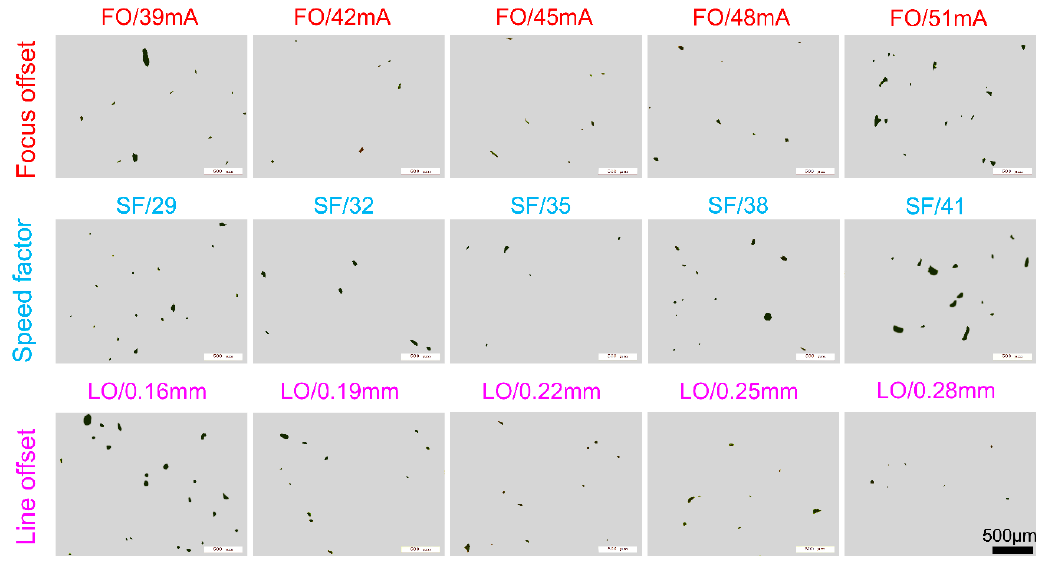
Figure 7. Effect of various process parameters on the porosity of EBM Ti-6Al-4V specimens. Figure 7. E ff ect of various process parameters on the porosity of EBM Ti-6Al-4V